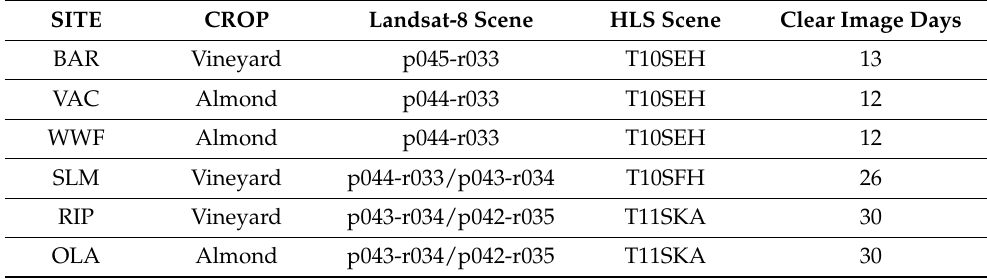
Table 1. Landsat 8 Collection 2 and HLS scenes used for each site. Additionally included are the number of images used for each site during the period of study (2021). Note more clear image days for sites with overlapping Landsat